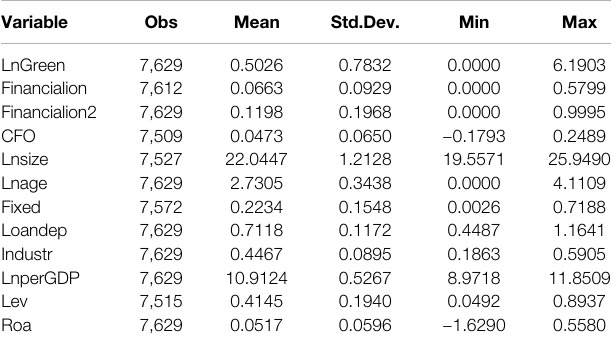
TABLE 2 | Descriptive statistics for variables.